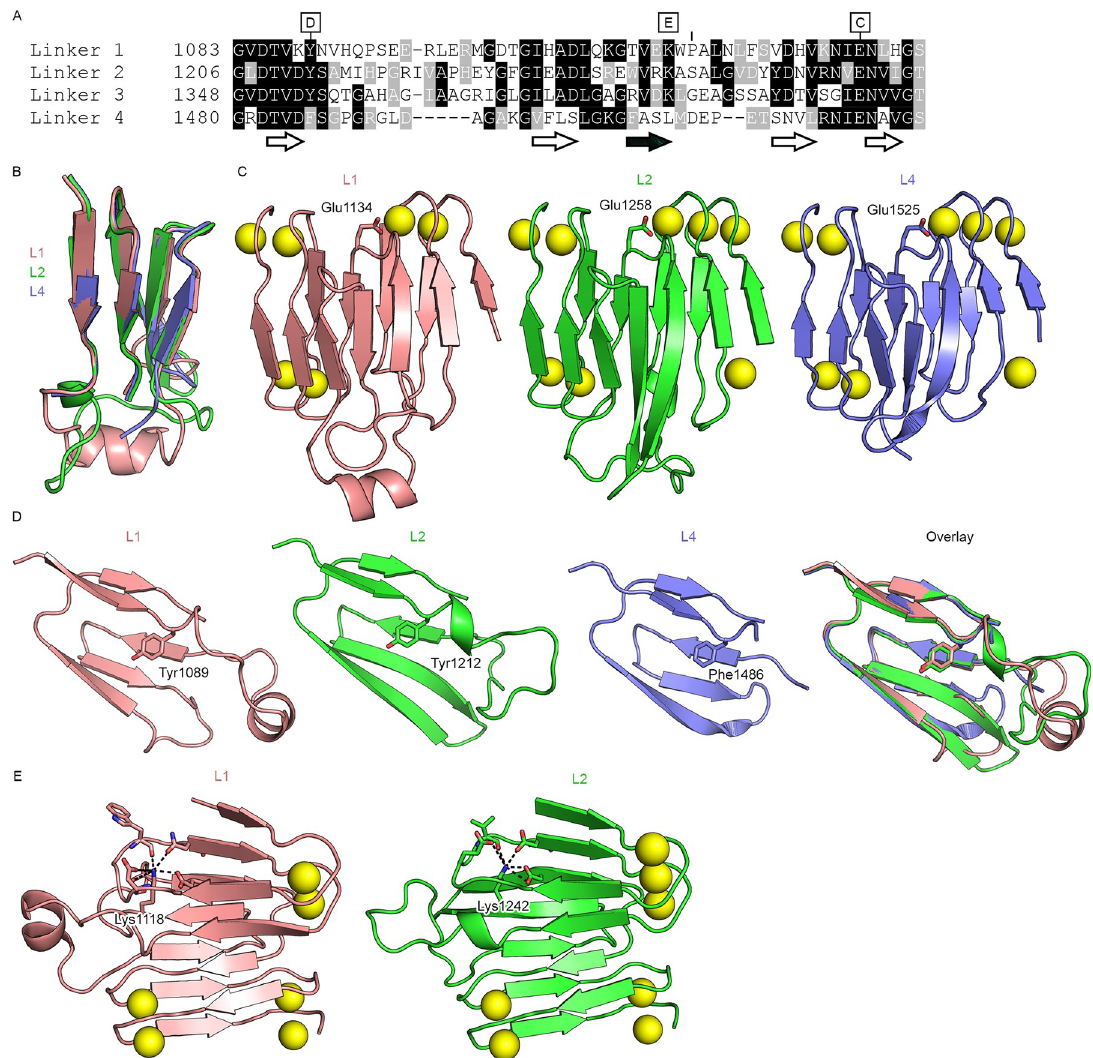
Fig 3. The ACT inter-block linkers are conserved modules. (A) Sequence alignment of L1, L2, L3, and L4 from B . pertussis ACT. The locations of the core β -sheets are shown below the alignment, with the antiparallel β -strand shown with a black fill. Letters above the alignment denote the subsequent panels that highlight the specified residue. (B) Structural alignment of L1, L2 and L4 (L4 from PDB ID: 6SUS). (C) Conserved Ca 2+ -binding glutamate at the C-termini of L1, L2, and L4. (D) Conserved core tyrosine/phenylalanine at the N- termini of L1, L2, and L4. (E) Partially conserved buried lysine residue in L1 and